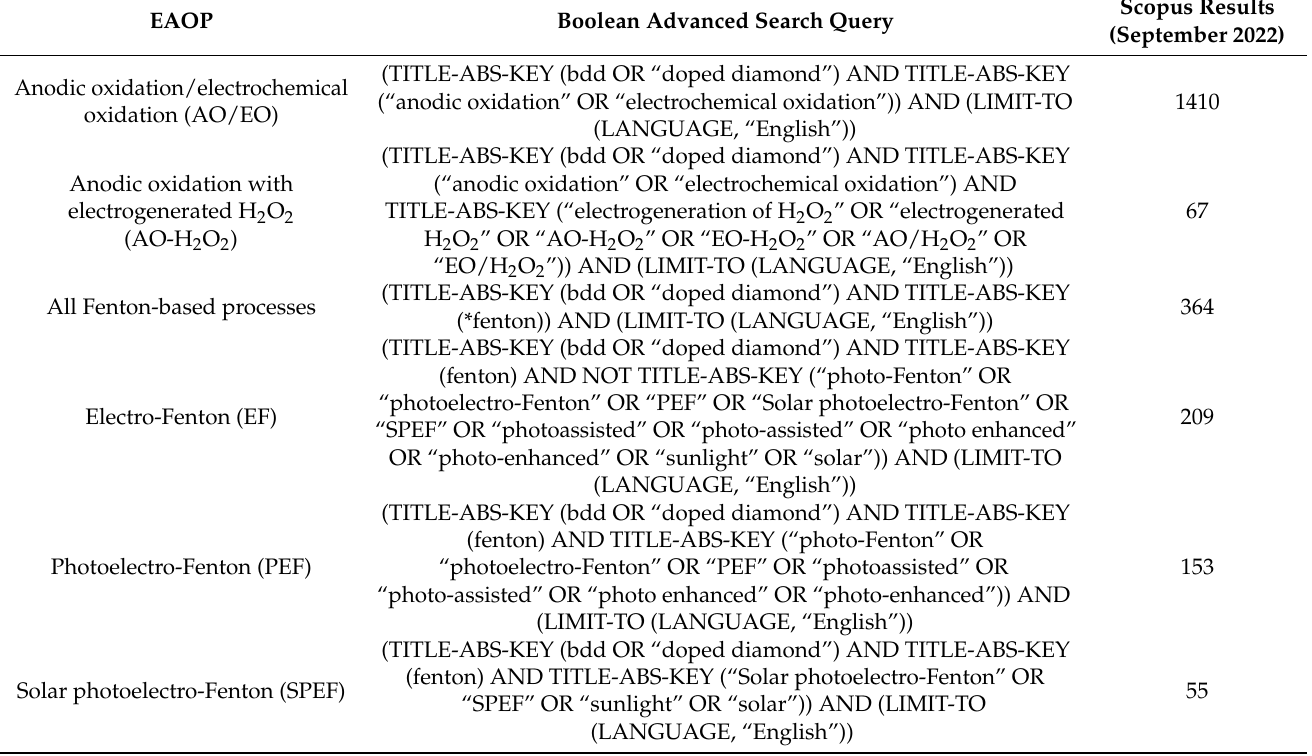
Table 1. Details of the advanced Boolean search queries performed in the Scopus database regarding the most applied EAOP type using diamond technology (source: the